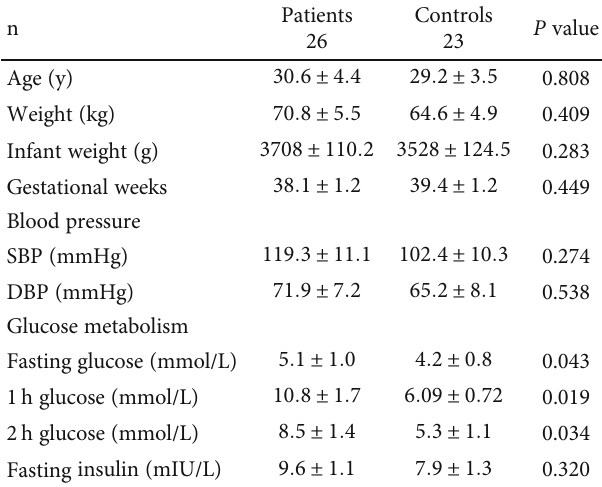
Table 1: Characteristics of patients and controls.